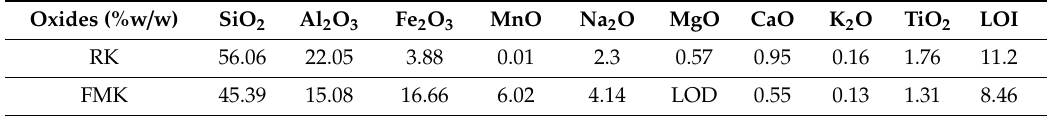
Table 1. Chemical composition of raw kaolin (RK) and FMK.